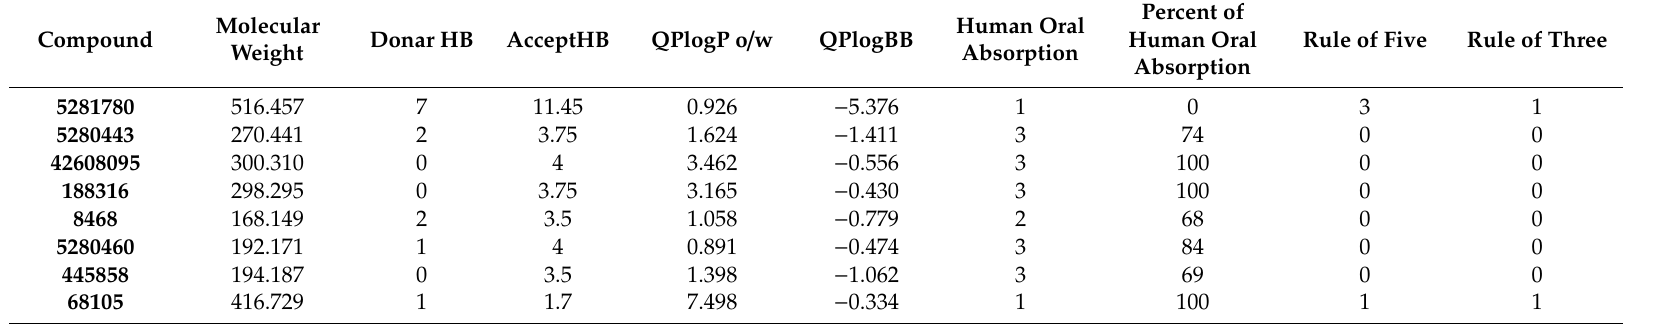
Table 2. Selected properties predictions obtained from QikProp tool of Schrodinger for the set of